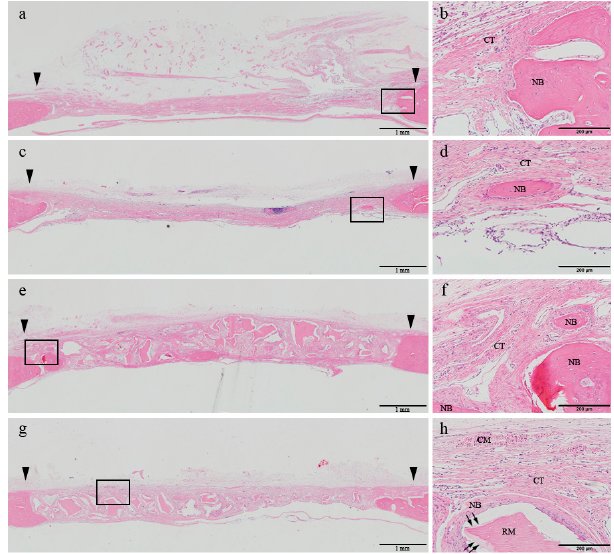
Figure 3. Histologic transversal sections obtained at 8 weeks after surgery (hematoxylin and eosin staining). ( a , b ) Control group; ( c , d ) DHT membrane group; ( e , f ) BG group; ( g , h ) DHT + BG group. The boxed areas in the left panels (40× magnification) are magnified in the corresponding panels on the right (200×). Arrowhead: defect margin. CT: connective tissue; NB (black arrow): new bone; CM: collagen membrane; RM: residual material.